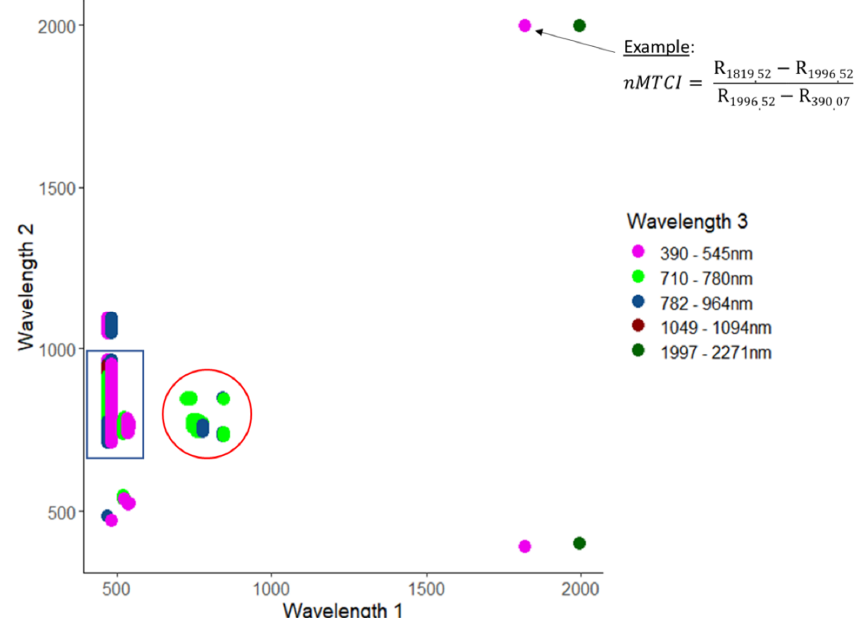
Figure 3. 3-D correlation matrix of CCC and narrowband MERIS terrestrial chlorophyll index (MTCI) for all combinations of wavelengths that yielded R 2 values of 0.6 or higher (not cross-validated). The arrow in the top right corner points to the location that indicates the index with the optimal wavelength combination. The blue rectangle indicates the band combinations with wavelength 1 in the green region, wavelength 2 in the red edge region and wavelength 3 in one of the listed regions except shortwave infrared. The red circle shows the band combinations with all three wavelengths in the red edge. Remote Sens. 2020 , 12 , x FOR PEER REVIEW